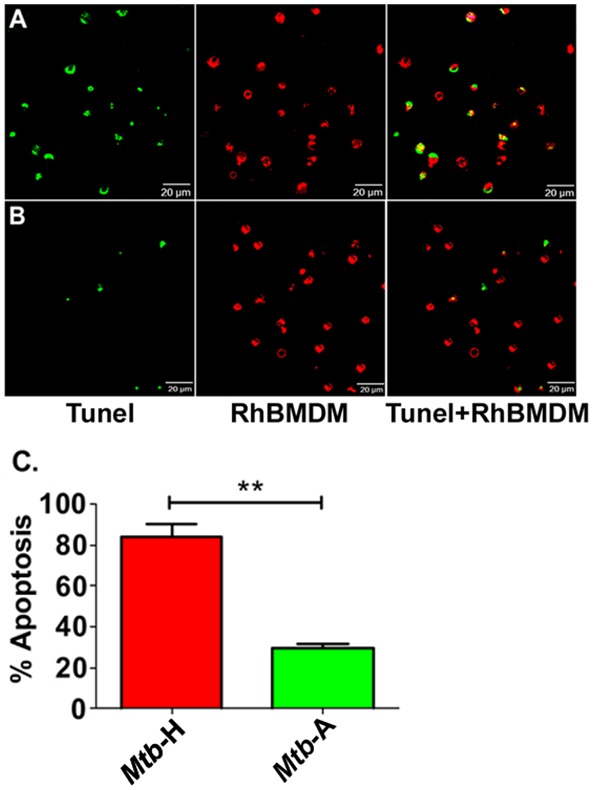
Functional validation of differential apoptosis in Rh-BMDMs infected with Mtb-H or Mtb-A by Tunel assay.Apoptotic cells show Tunel-positive nuclei (green) and Rh-BMDMs (red). Representative results are shown for Rh-BMDMs infected with Mtb-H (A) and the Mtb-A (B) at the 24-hr post-infection. (C) Graph (from Figure 1A and B) shows percentage of Rh-BMDMs undergoing apoptosis after 24 hours of exposure to Mtb-H or Mtb-A quantified by in situ Tunel assay. ** Student’s t test, p<0.005.